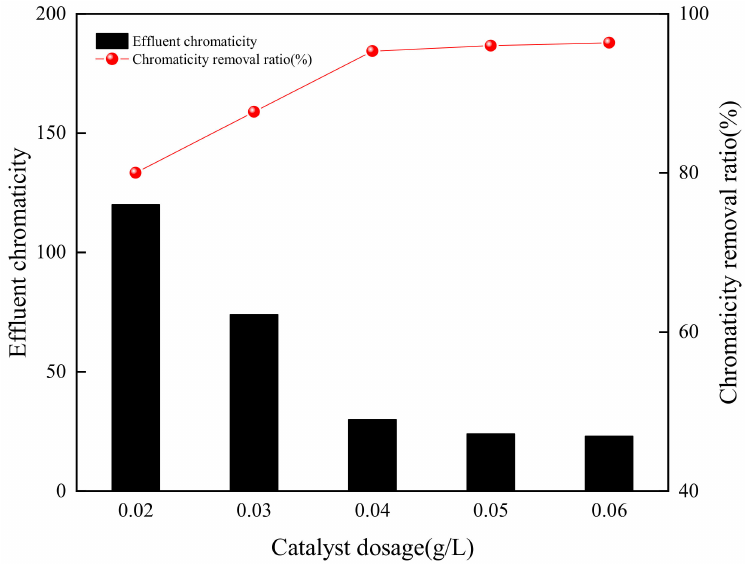
Figure 8. Effect of GAC dosage on chromaticity removal (pH value = 3, O 3 concentration = 6 mg/L, ozonation time = 40